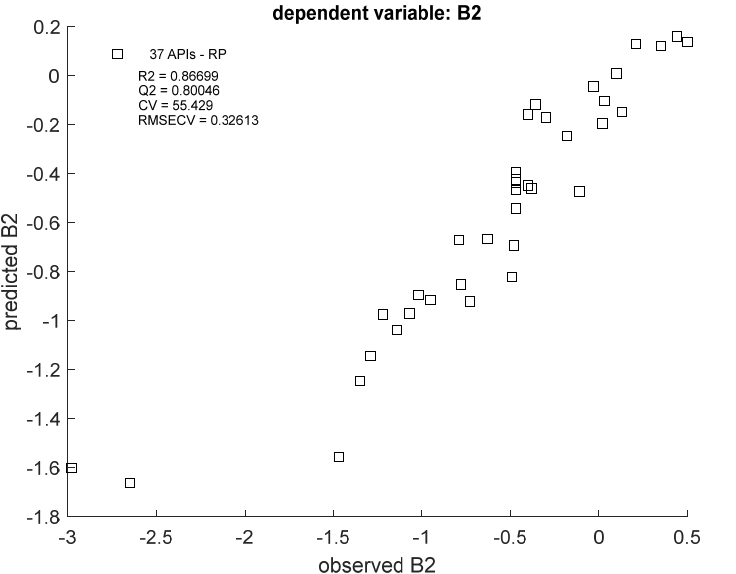
Figure 3. Scatter plot of predicted vs. observed B2 values in RF model, using RP TLC data. R2 = coefficient of determination; Q2 = coefficient of determination for the cross-validated models; RMSECV = root-mean-square error of cross-validation.